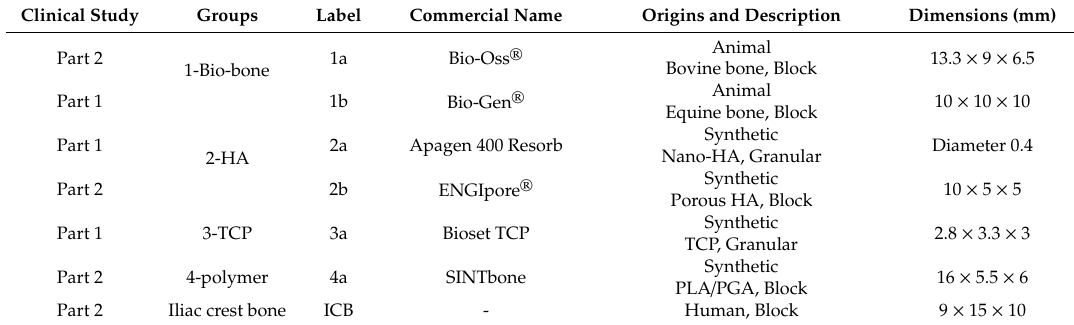
Table 1. Biomaterials selected for the